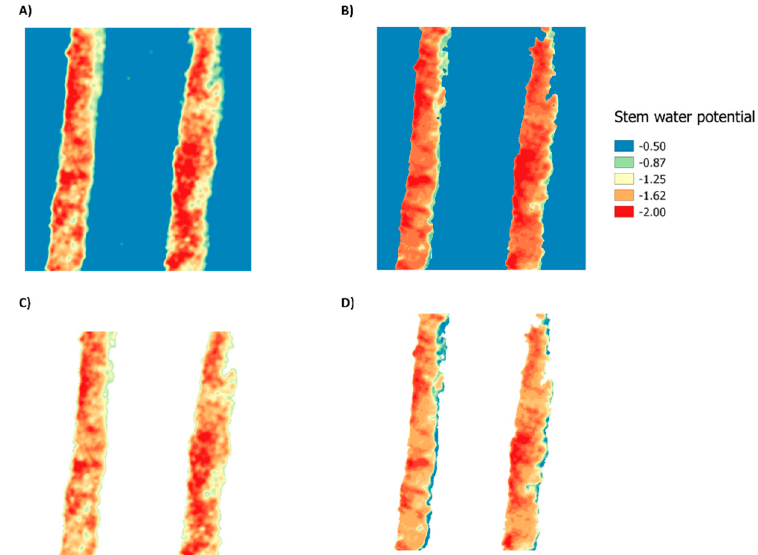
Figure 3. Examples of soil–canopy pixel distinction by the mask application based on the NDVI threshold for NDVI and artificial neural network model ANN-2. ( A ) NDVI soil–canopy information. ( B ) NDVI pure canopy. ( C ) ANN-2 soil–canopy information. ( D ) ANN-2 pure canopy.